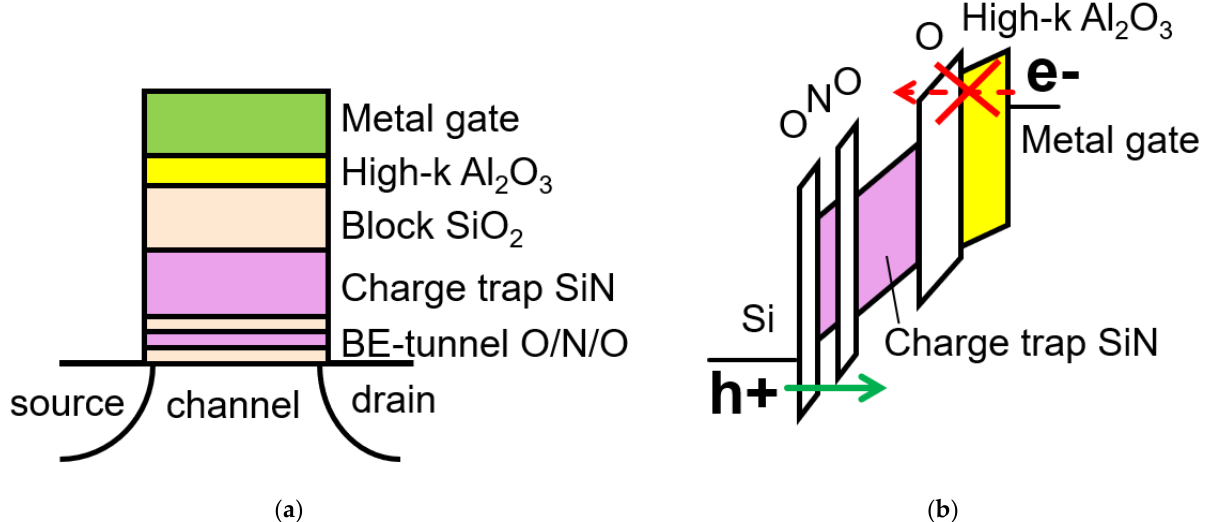
Electronics 2021 , 10 , x FOR PEER REVIEW Figure 7. ( a ) Cell film stack of the charge-trap cell. ( b ) Band diagram during erase of charge-trap cell. Band-engineered (BE) tunnel dielectrics enhances hole injections while High-k/Metal gate prevents electron back tunneling [35].